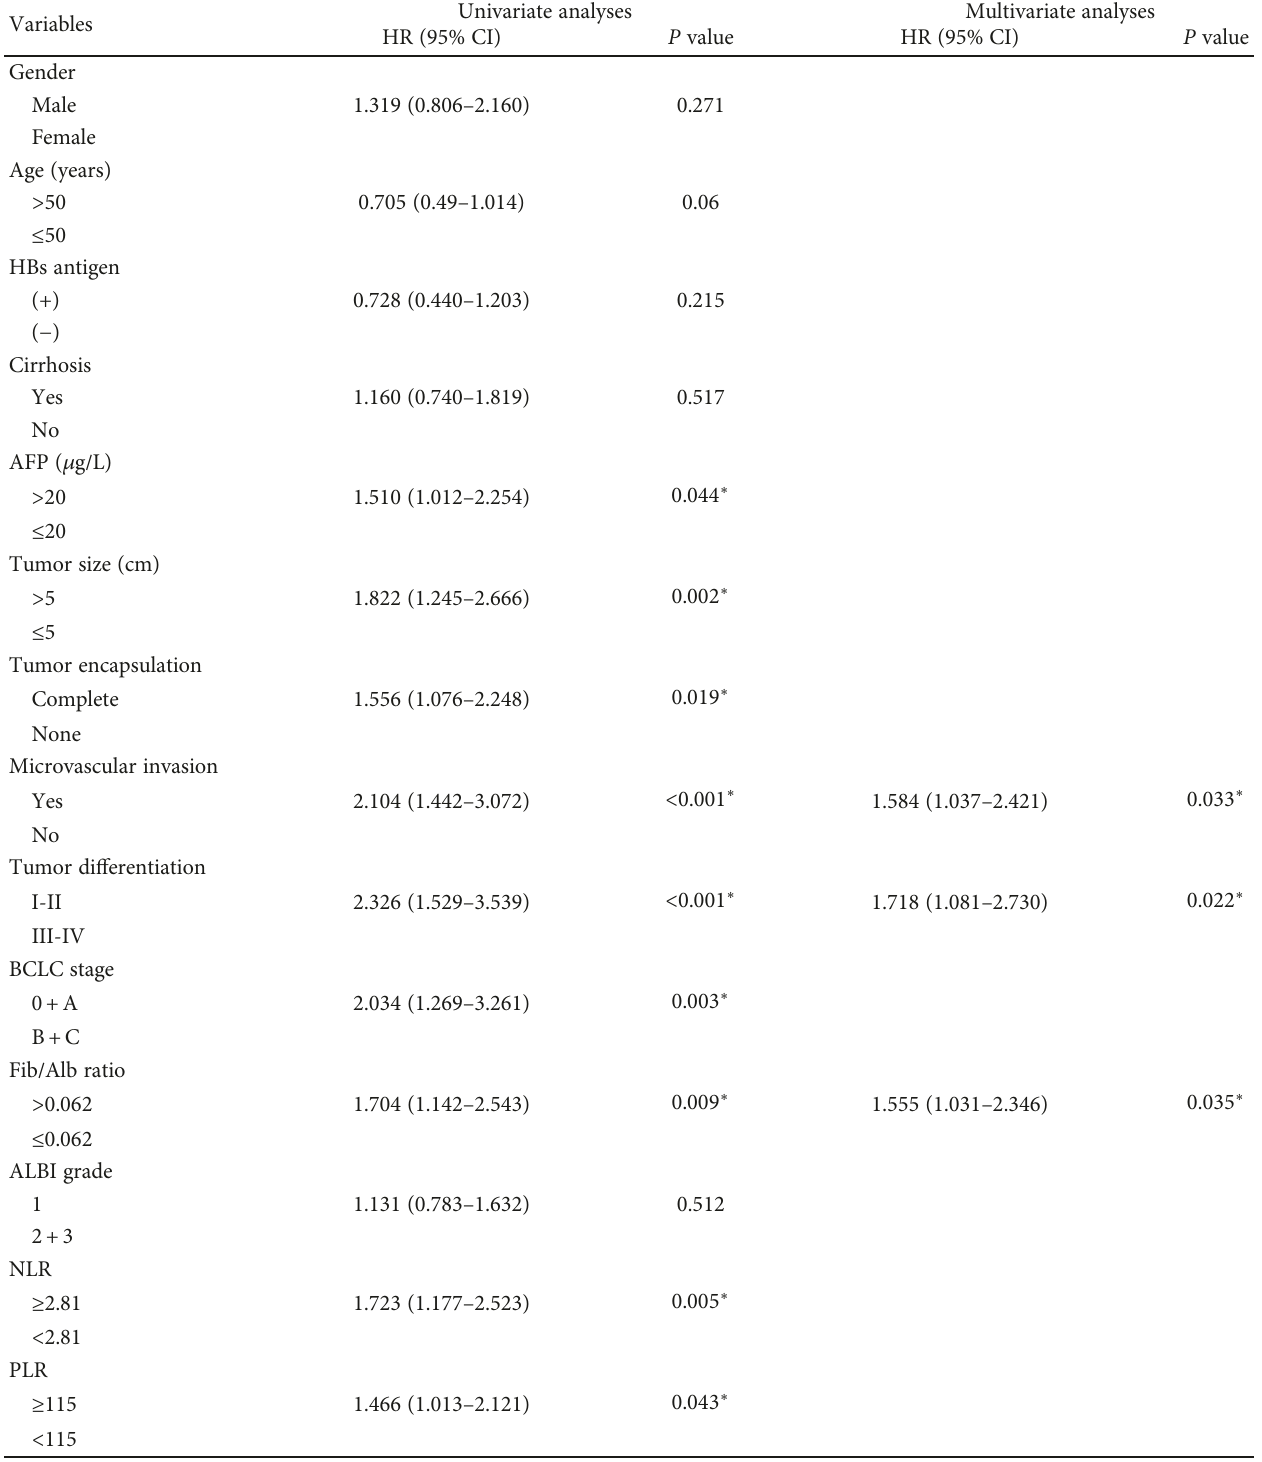
Table 3: Univariate and multivariate Cox regression analyses of prognostic factors for time to recurrence (TTR).